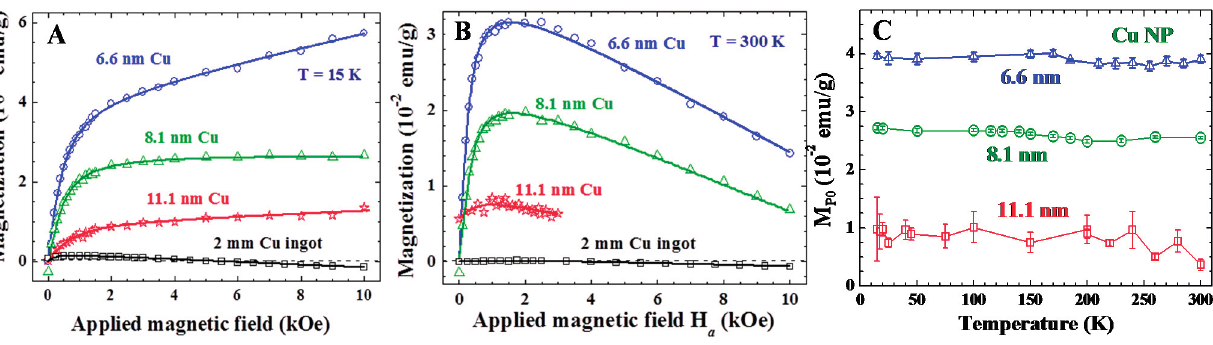
Figure 3. Isothermal M(H a ) curves of the three sets of Cu nanoparticle assemblies together with that of 2 mm Cu ingots at ( A ) 15 K and ( B ) 300 K. The solid curves indicate the results of the fit to the field profile discussed in the text; and ( C ) temperature dependencies of saturation spontaneous magnetization M P0 of the three sets of Cu nanoparticle